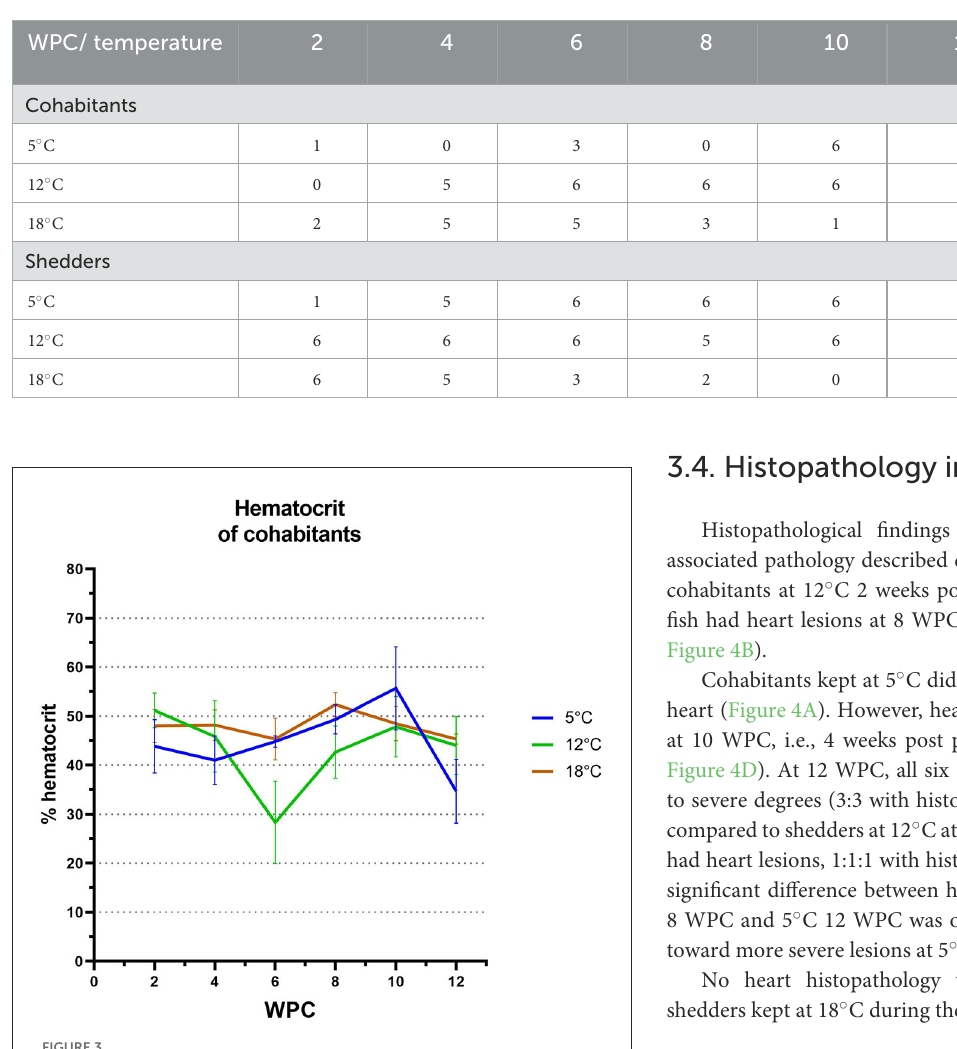
FIGURE3 Hematocrit levels of cohabitants exposed to PRV-3. Significant difference observed in PRV-3 exposed cohabitants at 12 ◦ C compared to 5 and 18 ◦ C at six WPC ( p = 0.05 and p = 0.026, respectively). Likewise, a significant difference was observed at 5 ◦ C compared to 12 and 18 ◦ C at 12 WPC ( p = 0.026 and p = 0.0096, respectively). Error bars show